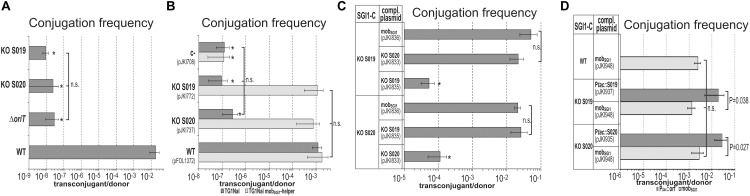
Mutation and complementation analysis of S019 and S020. (A) Transfer frequency of SGI1-C KO mutants. SGI1-CWT and the KO mutants were mobilized by the R55ΔTn6187 helper plasmid from TG1Nal strain into TG2 recipient. The asterisk indicates that the transfer frequency was close to the detection limit. In case of SGI1-CΔoriT the high rate of co-transfer with R55 among the sporadically occurring transconjugants refers to an oriTSGI1-independent way, while transconjugants of KO S019 and S020 SGI1-C mutants did not contain the helper plasmid and might derive via a yet unexplored way of in trans mobilization or lost the helper plasmid after conduction. (B) Transfer frequency of S019 and S020 KO mutant mobSGI1 regions cloned in pJKI708. In the mating assays TG1Nal/R55 or TG1Nal::mobSGI1/R55 strains containing the KO mutant or control plasmids were used as donor strains and TG2 was the recipient. Basal level of plasmid transfer (including the negative control plasmid pJKI708) indicated by asterisk did not result from regular in trans mobilization (high co-transfer rate with R55). (C)
Trans-complementation of SGI1-CΔS019 and SGI1-CΔS020 by the respective KO mutant mobSGI1 regions. Donor E. coli strains TG1Nal::SGI1-CΔS019 and TG1Nal::SGI1-CΔS020 carried the helper plasmid R16a and one of the complementing plasmids containing the WT, KO S019 or KO S020 mobSGI1 region (pJKI836, pJKI835or pJKI833, respectively). ∗ Transconjugant frequency was below or around the detection limit. The relatively high detection limit was due to the lower donor titers compared to other matings (1.2–8.2 × 106 CFU/ml instead of the general 2–5 × 109 CFU/ml) in this experimental setup that was caused by the presence of two plasmids along with SGI1 in the donor strains. (D)
Trans-complementation of SGI1-CΔS019 and SGI1-CΔS020 by expression of S019 or S020 proteins. Mating assays were performed using the recipient strain TG2 and donor strains TG1Nal::SGI1-CWT, TG1Nal::SGI1-CΔS019, or TG1Nal::SGI1-CΔS020 harboring the helper plasmid R16a and one of the complementing plasmids: pJKI948 contained the mobSGI1 region, while pJKI937 and pJKI935 expressed S019 and S020, respectively, from Ptac promoter. Protein expression was driven by leakage of the tac promoter (without IPTG induction).